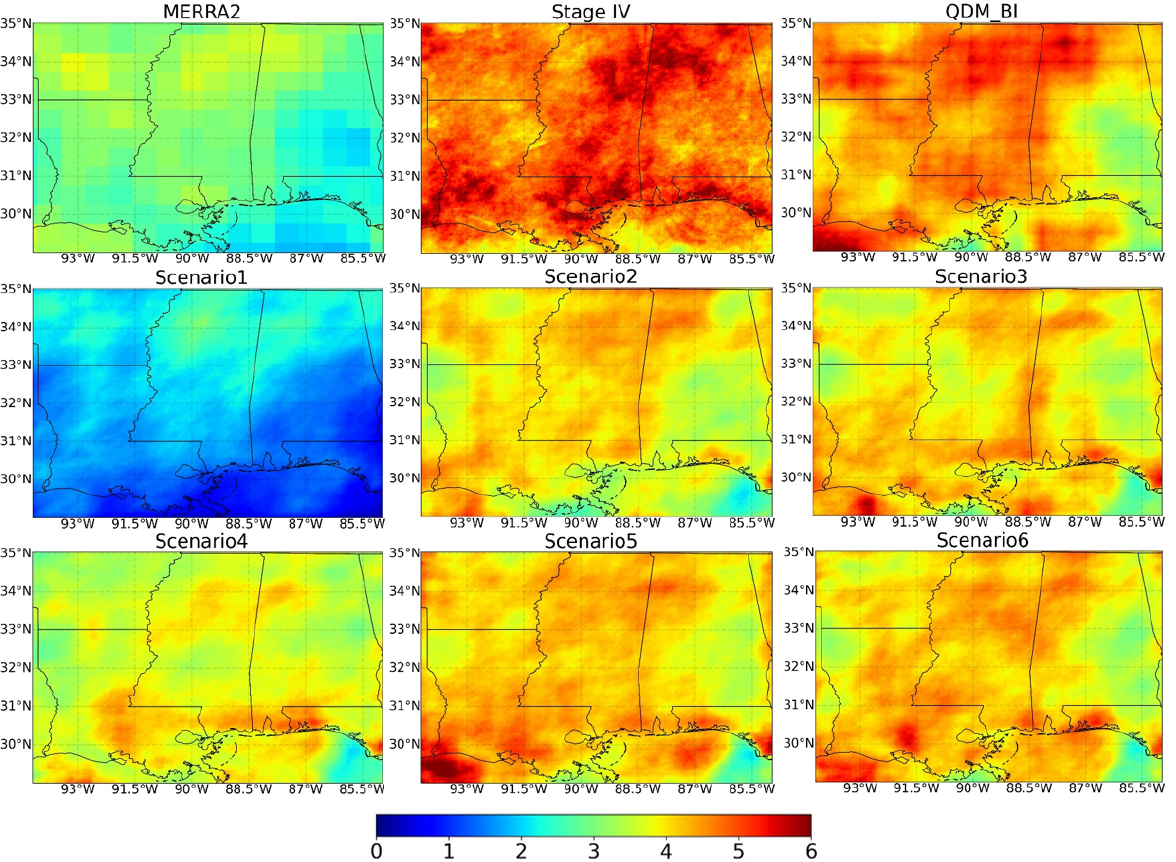
Figure 7. Spatial map of hourly precipitation extremes at the 99th percentile (in a unit of mmh − 1 ) from raw MERRA2, Stage IV, QDM_ BI, and the 6 DL experimental runs